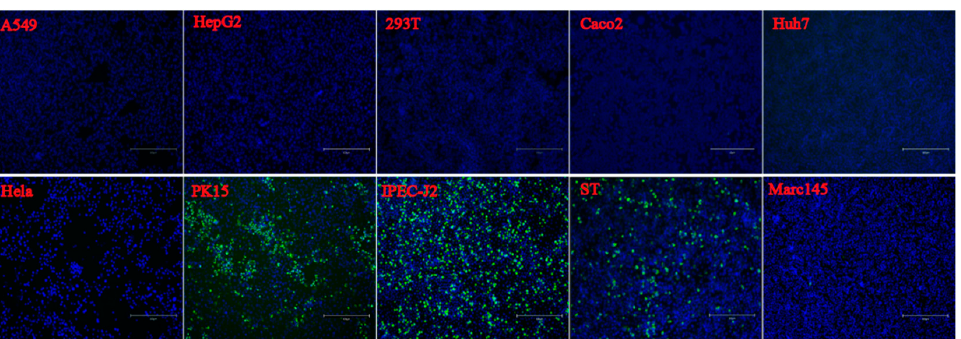
Figure 4. Identification of mAb against VP1 of PSV. ( A ) Identification of mAb against PSV-VP1 by IFA. PK15 cells infected with PSV at MOI of 0.01. IFA was performed using generated mAb against VP1. ( B ) Western blot analysis of the purified recombinant protein from E. Coli . Lane M, protein marker; Lane 1, 0.1 mg/mL purified MBP-tagged VP1-recombinant protein; Lane 2, 0.2 mg/mL MBP-tagged VP1-recombinant protein; Lane 3, purified MBP. ( C ) Western blot analysis of the expressed MBP in empty vector. Lane M, protein marker; Lane 1, sediment of bacterial cell lysate, Line 2, supernatant